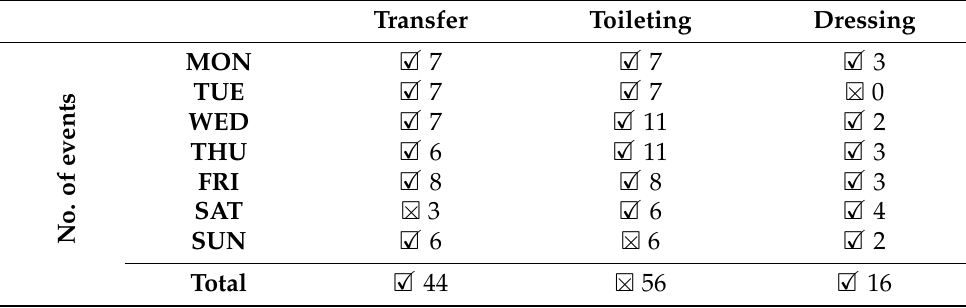
Table 18. Results of the second scenario.